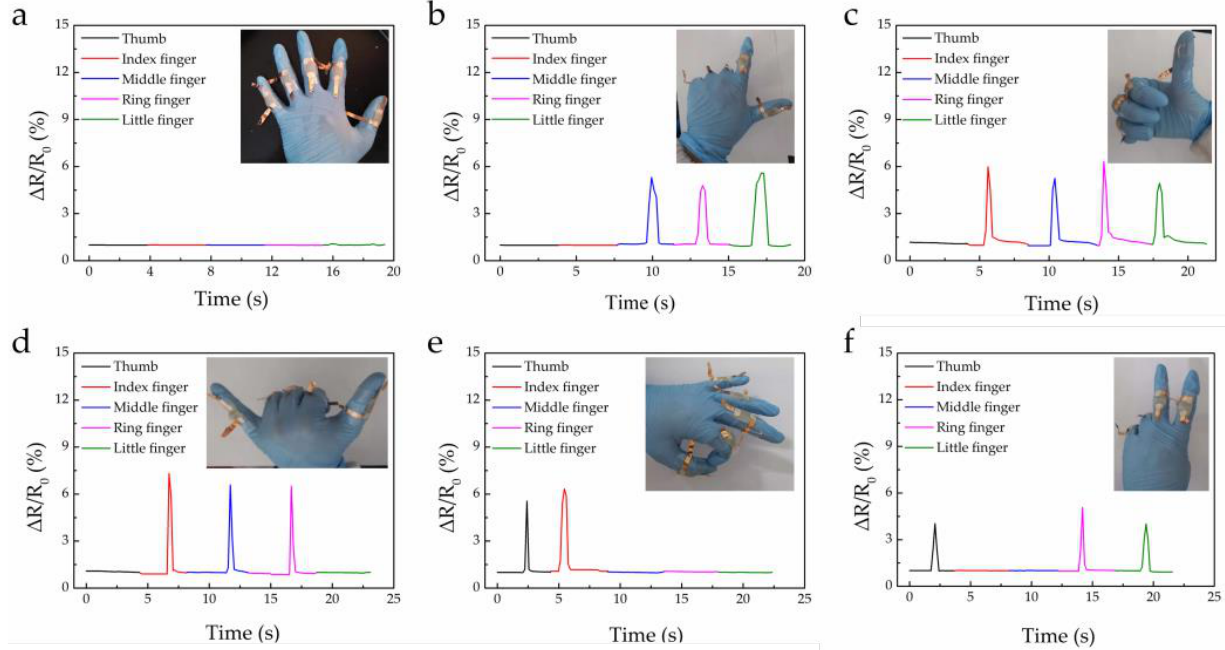
Figure 4. Resistance response to different gestures of human body for strain sensor.